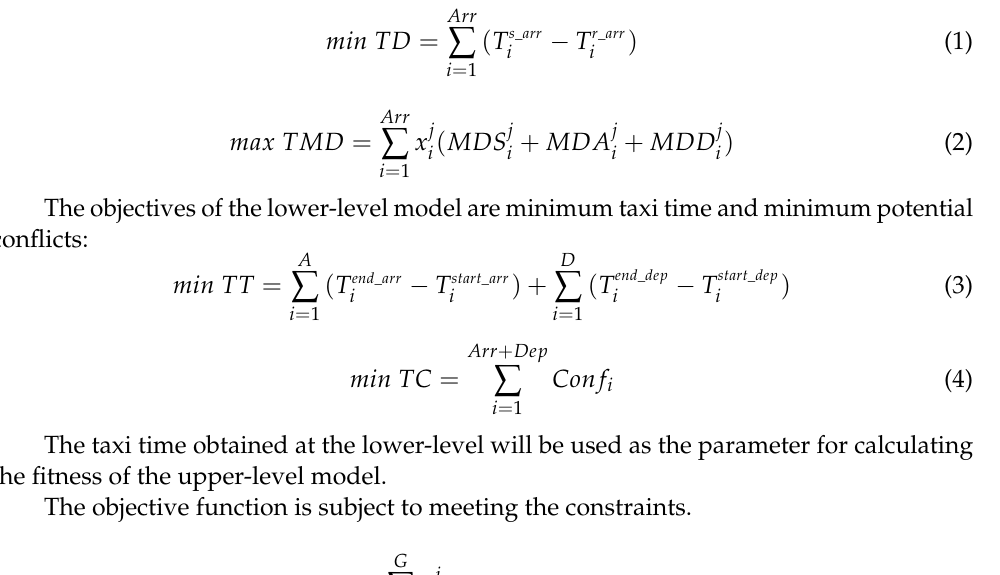
Table 2. Cont . MDS j i